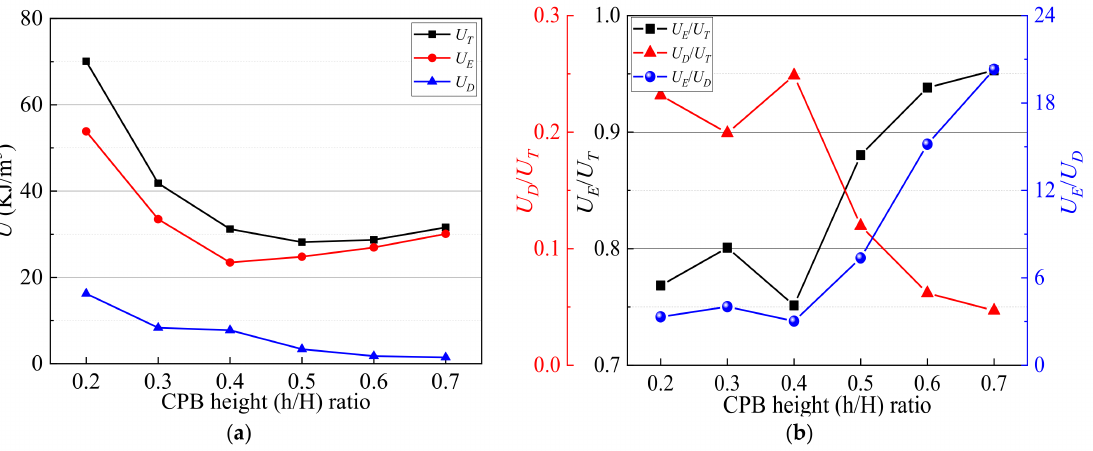
Figure 12. Energy dissipation and energy dissipation ratio of RCF sample at peak point: ( a ) energy dissipation; ( b ) energy dissipation